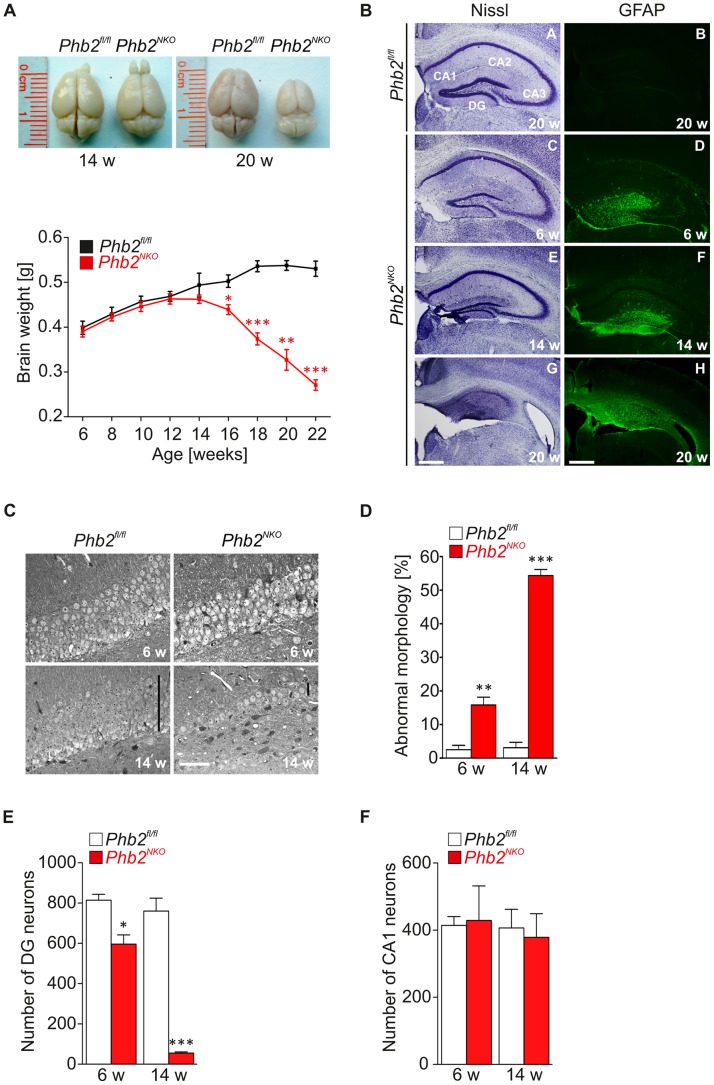
Progressive astrogliosis and loss of hippocampal neurons in Phb2NKO mice.(A) Representative photographs of brains isolated from 14- or 20-week-old Phb2NKO and Phb2fl/fl control mice (upper panel). Brain weights of Phb2NKO and Phb2fl/fl control animals were monitored at the indicated time points (lower panel). n = 5 per genotype and time point, *P<0.05; **P<0.01; ***P<0.001. Error bars indicate SEM. (B) Nissl staining of coronal sections across the hippocampal region from Phb2NKO and Phb2fl/fl control brains of the indicated age (left panel). Immunohistochemistry using GFAP antibody reveals progressive astrogliosis in the hippocampus of Phb2NKO mice (right panel). Scale bars: 400 µm. (C) Coronal semithin sections of the hippocampal DG from 6-week (upper panel) or 14-week-old (lower panel) Phb2NKO and Phb2fl/fl control mice. Black vertical bars show the thickness of the neuronal layers. White scale bar: 40 µm. (D) Quantification of neurons with degenerative features and vacuolization in the DG of Phb2NKO and Phb2fl/fl control mice of the indicated age. Data are expressed as percentage of total cells counted. At least 200 cells were scored per section; in case of the Phb2NKO at 14 weeks all residual neurons were scored. Error bars indicate SEM (n = 3). (E) Number of DG and (F) CA1 neurons in 6- and 14-week-old Phb2NKO mice. Error bars indicate SEM (n = 3).